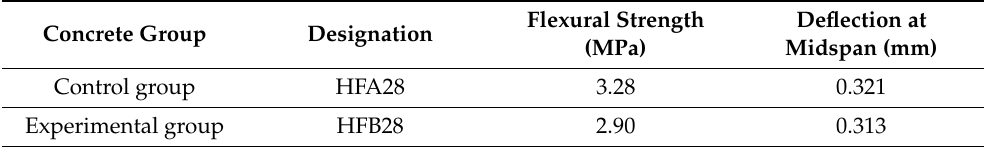
Table 23. Relative-flexural-strength ratios of the self-healing concrete after exposure to high temperature.